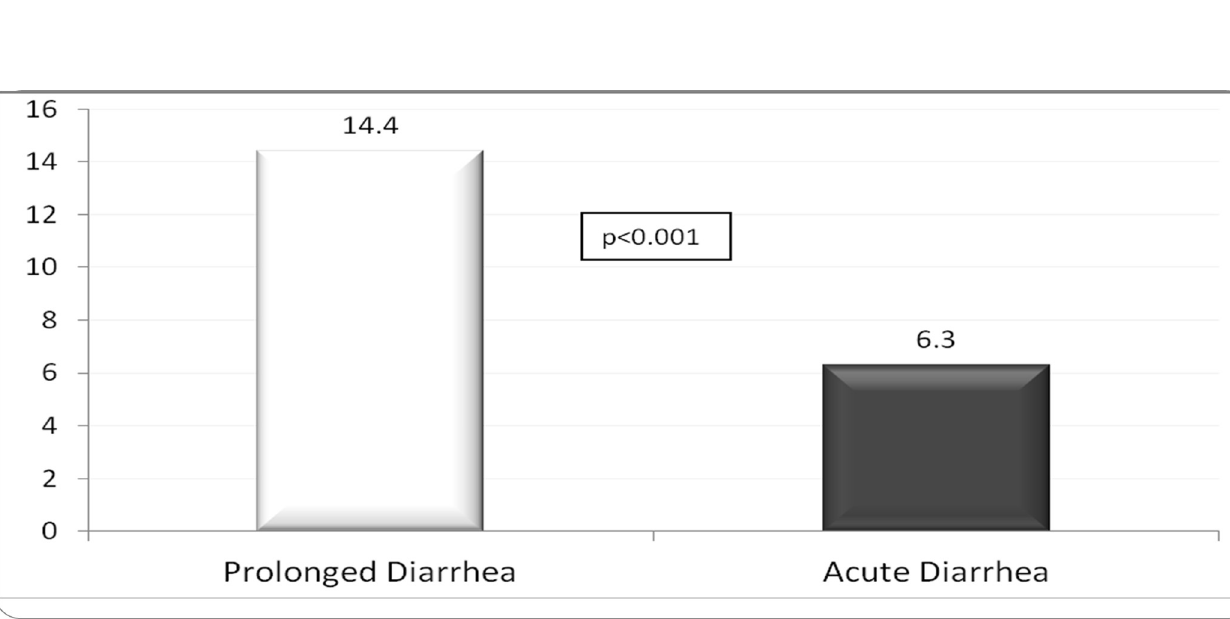
PLOS ONE | https://doi.org/10.1371/journal.pone.0273148 October 3,